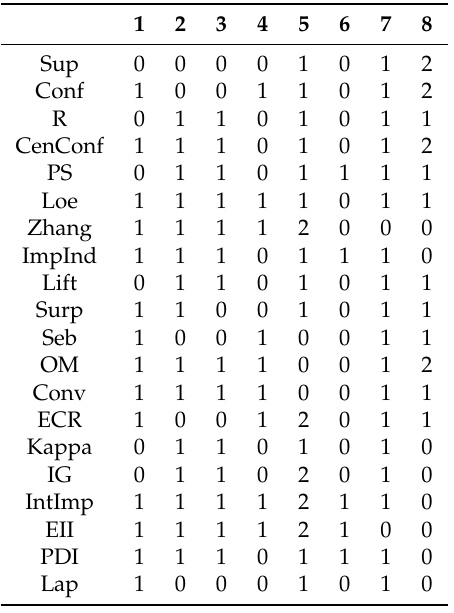
Table 4. The partial evaluations of 20 alternatives on 8 criteria. 1